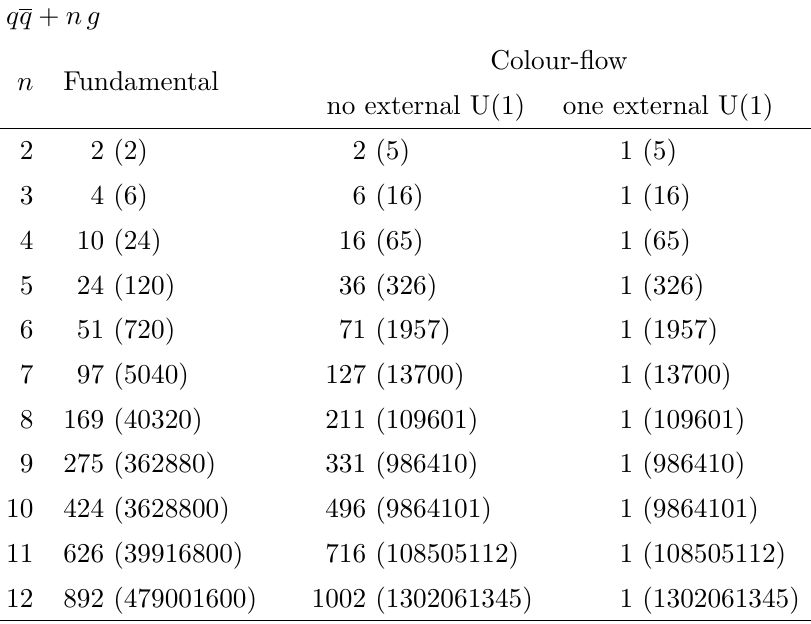
Table 3 . Number of non-zero elements in a single row of the colour matrix for qq + n g matrix elements up to NLC accuracy, O ( N n − 1